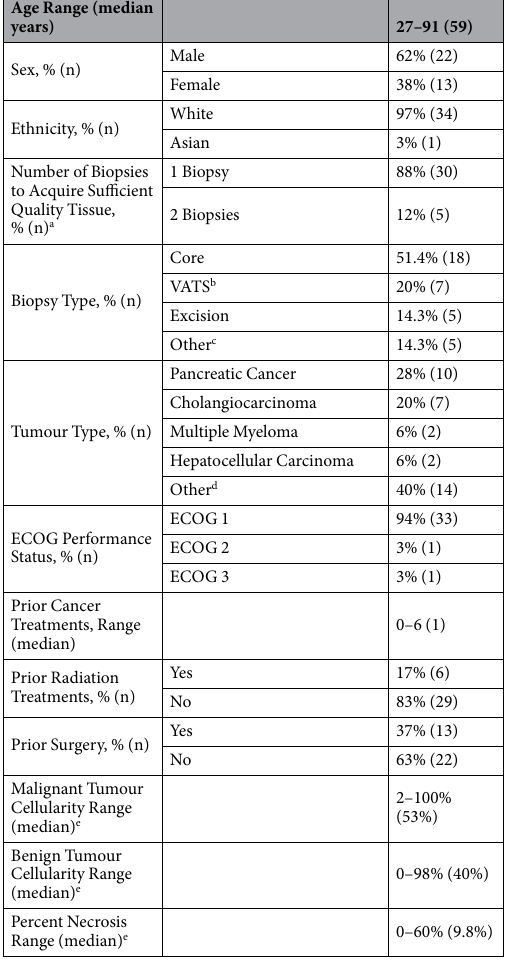
Table 1. Demographics and pathological characteristics. a For one patient, sufficient tissue for analysis could not be obtained. b Video-assisted thoracic surgery. c One each: laparatomy , esophagogastroduodenoscopy (EGD), debulking, tonsillectomy, bronchoscopy. d One each: liposarcoma, stomach cancer, oropharynx cancer, gastroesophageal cancer, cervical cancer, lung adenocarcinoma, gallbladder cancer, bladder cancer, basal cell carcinoma, melanoma, mesothelioma, testicular cancer, uterine cancer, renal cell carcinoma. e Calculated based on the average of all specimens collected for each individual